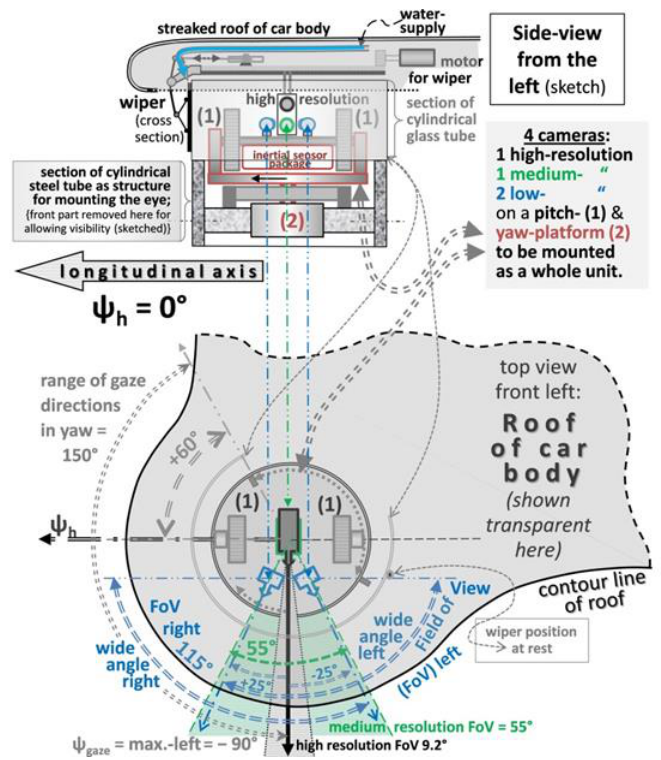
Figure 22. Gaze-controlled ‘Vehicle Eye’ (left side) at the upper end of the A-frame capable of providing tri-focal images in the same FoV as the body-fix eye in Figure 21; however, it has a data rate lower by two orders of magnitude, but with a delay time of a few video-cycles.